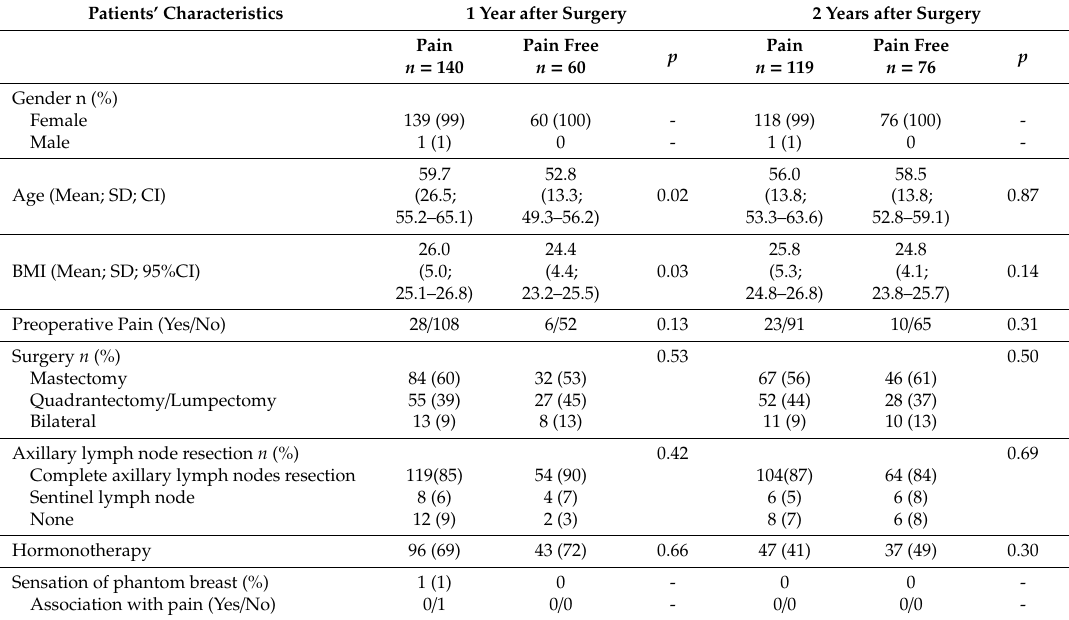
Table 4. Patients’ characteristics, with and without pain, 1 and 2 years after surgery. No statistically significant di ff erence after Bonferroni’s correction for multiple comparisons. p -values according to Chi square tests and Fisher exact tests as